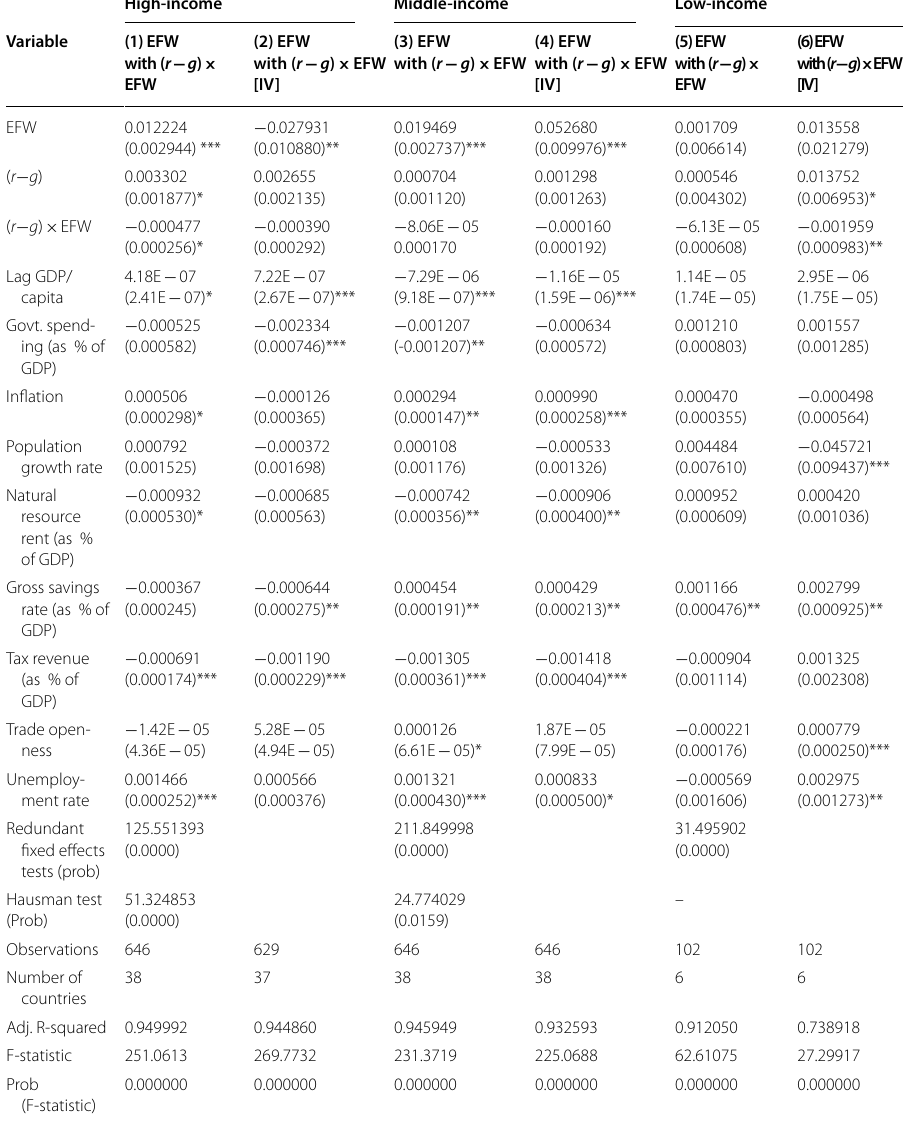
Table 4 Estimation results for high-, middle-, and low-income